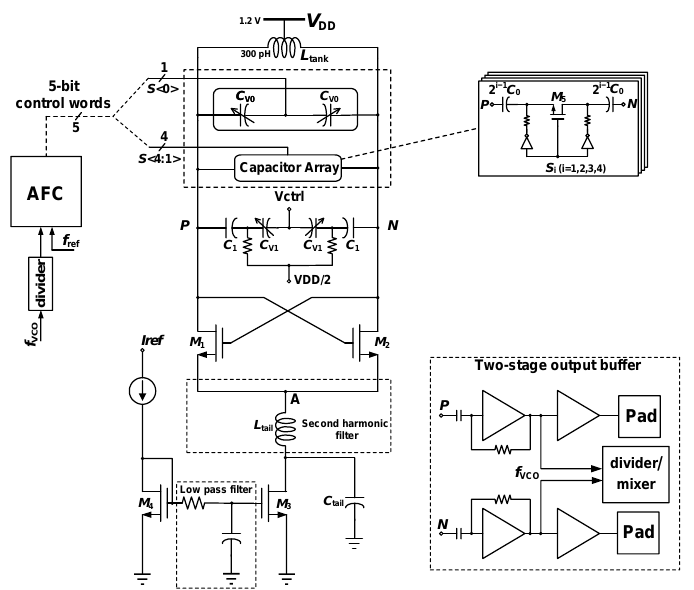
Figure 4. Schematic of the broadband LC voltage-controlled-oscillator